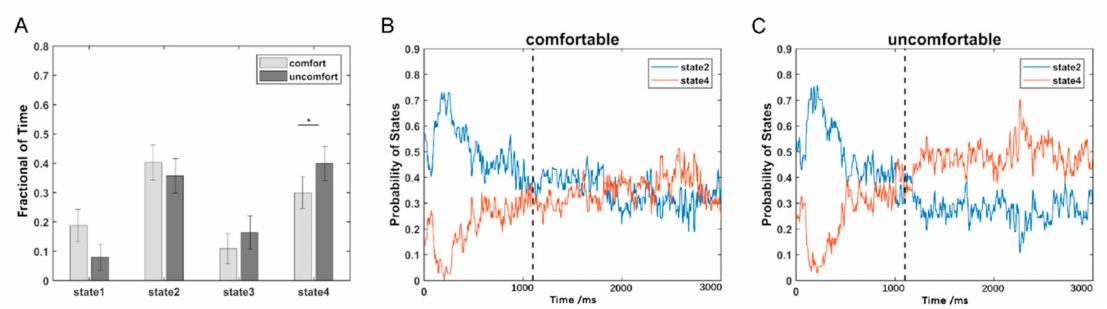
Figure 3. The temporal property comparisons of DFC: ( A ) comparison of the fraction of time between the visual comfort and discomfort conditions; ( B ) the probability variations of state 2 and state 4 with the time points for the visual comfort condition; ( C ) the probability variations of state 2 and state 4 with the time points for the visual discomfort condition. The star * represents p <